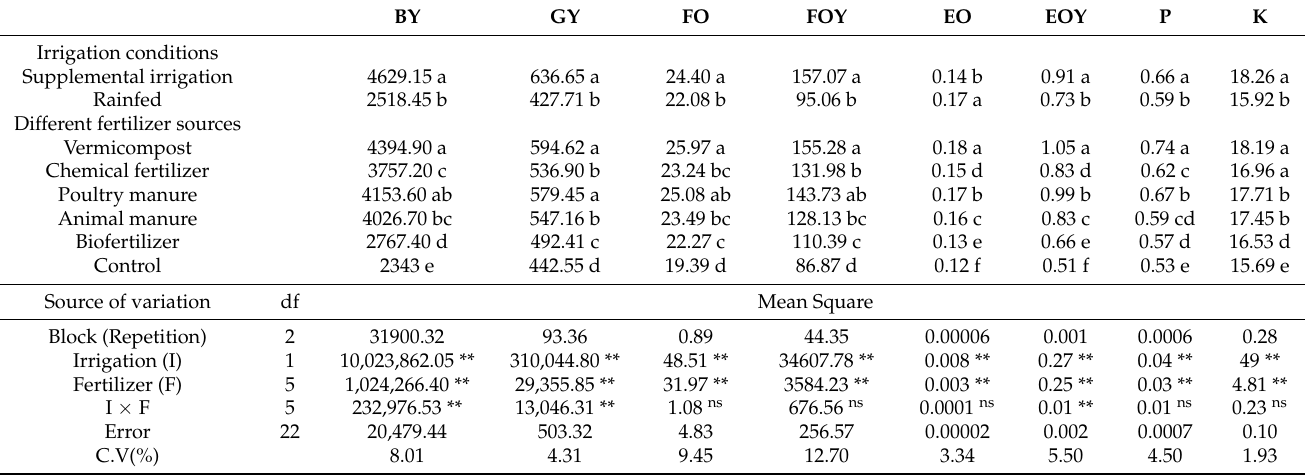
Table 3. Analysis of variance and comparison of means of content of elements and yield traits of dragon’s head plants in response to irrigation conditions (I), different fertilizer sources (F), and their interaction (I × F). Different letters in each column indicate significant differences according to Tukey’s HSD test ( p <